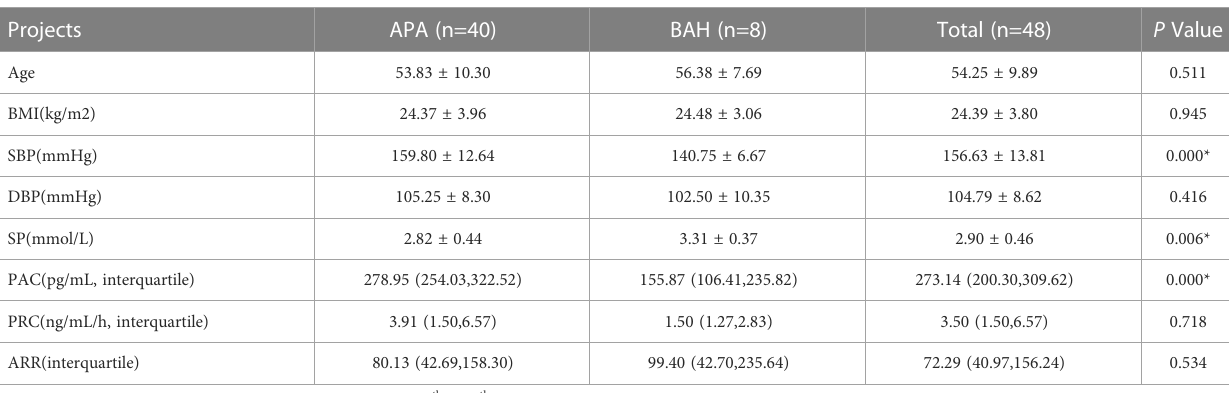
TABLE 1 Baseline characteristics of AVS patients.